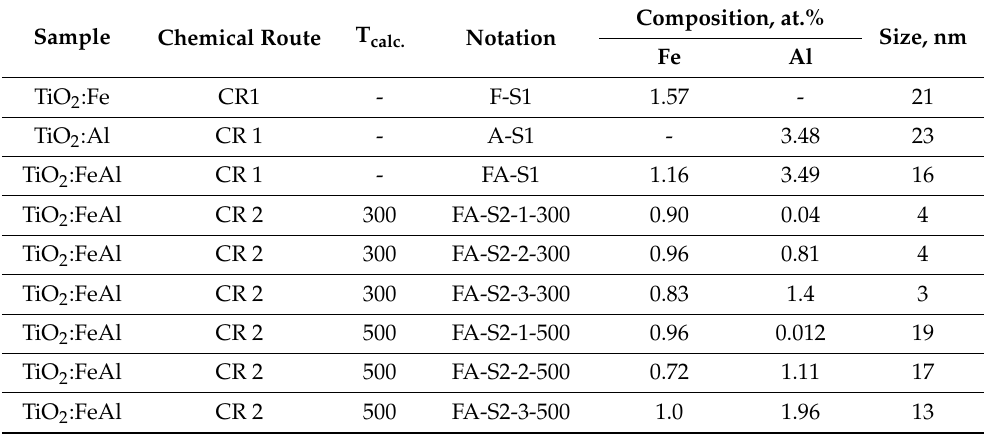
Table 1. The composition and the average particle size of the samples S1 and S2 sets. S2 samples were calcinated at 300 and 500 ◦ C. Particle sizes were estimated using the BET method. Sample Chemical Route T calc. Notation